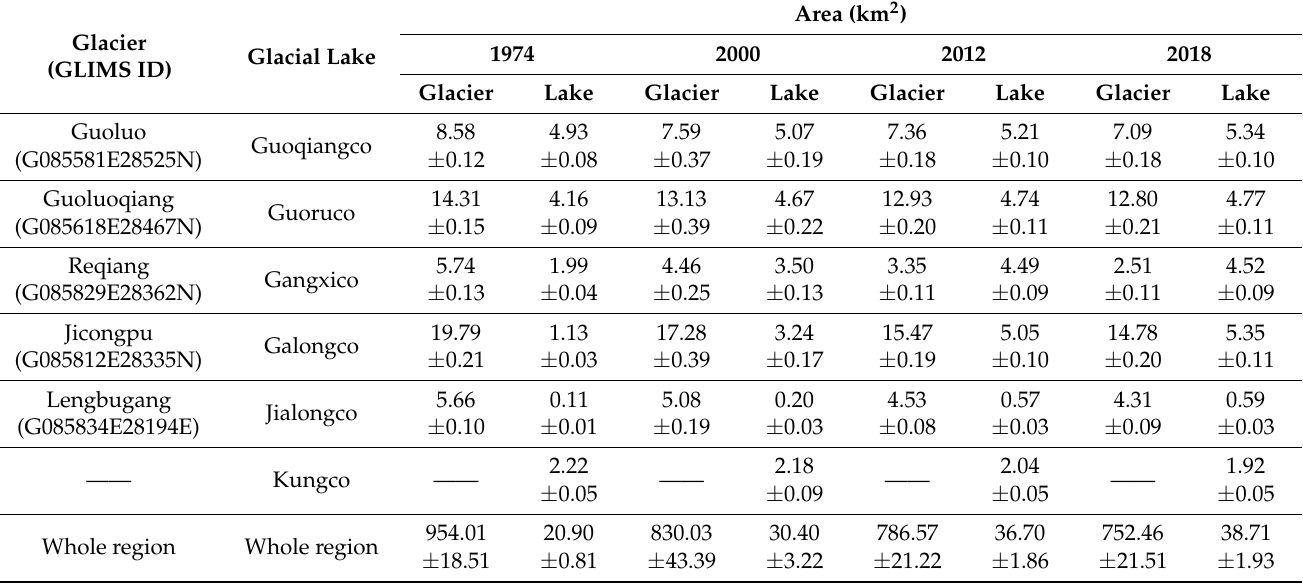
Table 4. Changes in glacier and glacial lake areas in the Xixabangma massif from 1974 to 2018. Area (km 2 ) Glacier 1974 Glacial Lake Glacier Lake Glacier Lake Glacier Lake Glacier